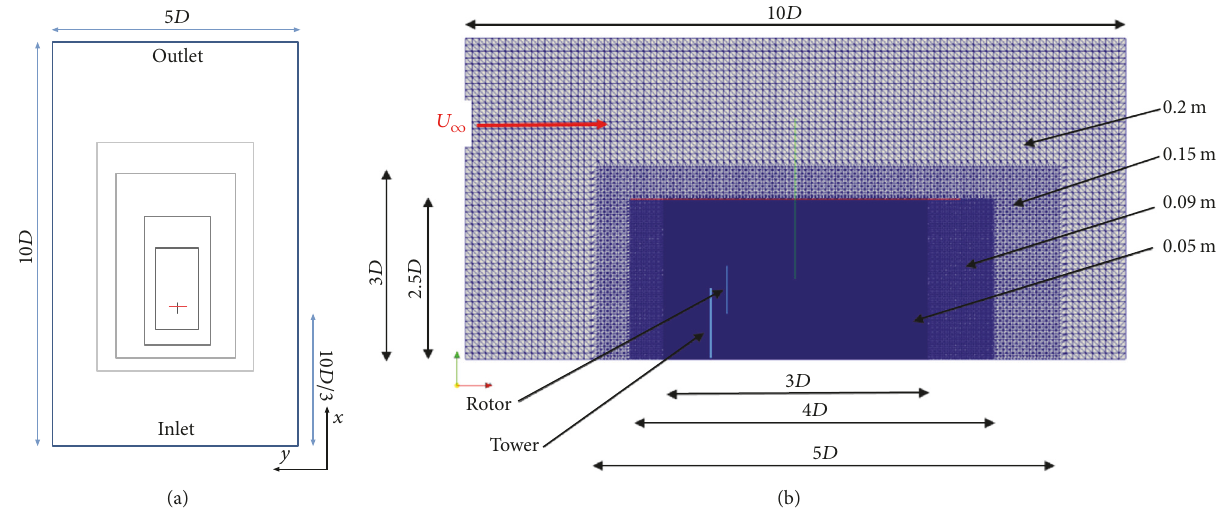
Figure 1: Schematic top view of the domain (a) and refinement boxes